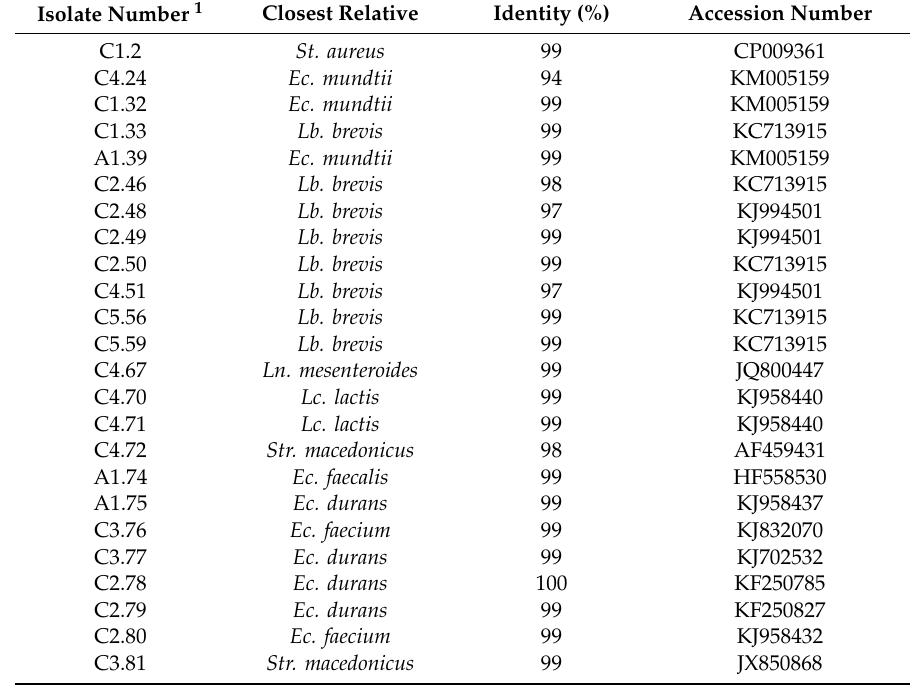
Table 4. Phylogenetic position of selected strains based on sequencing of V1–V3 region of 16S rRNA gene.